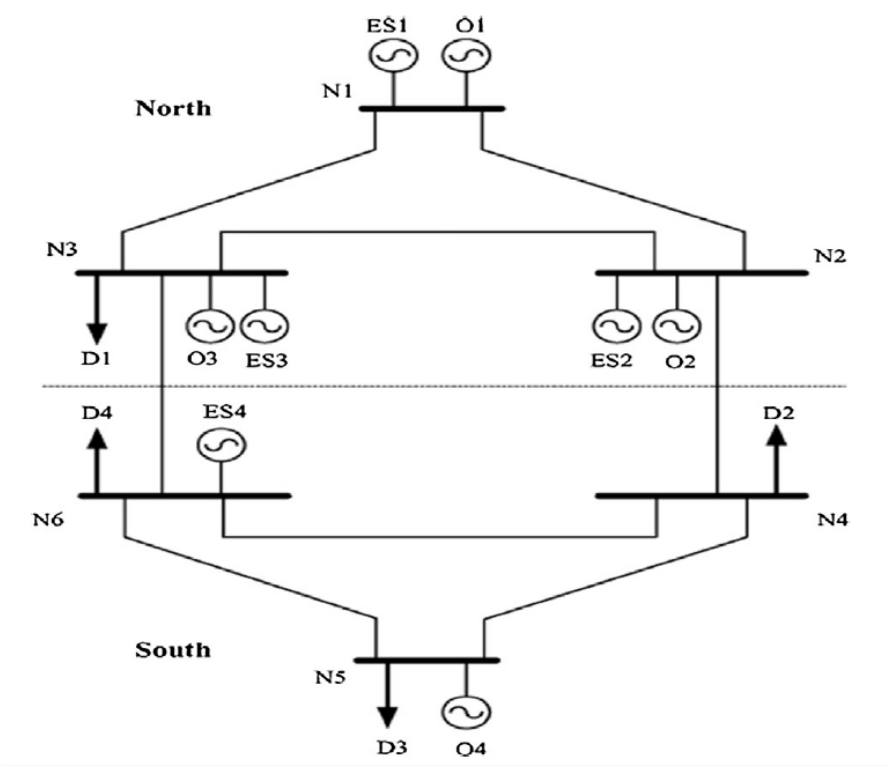
Figure 5. Parameters of energy generation expansion